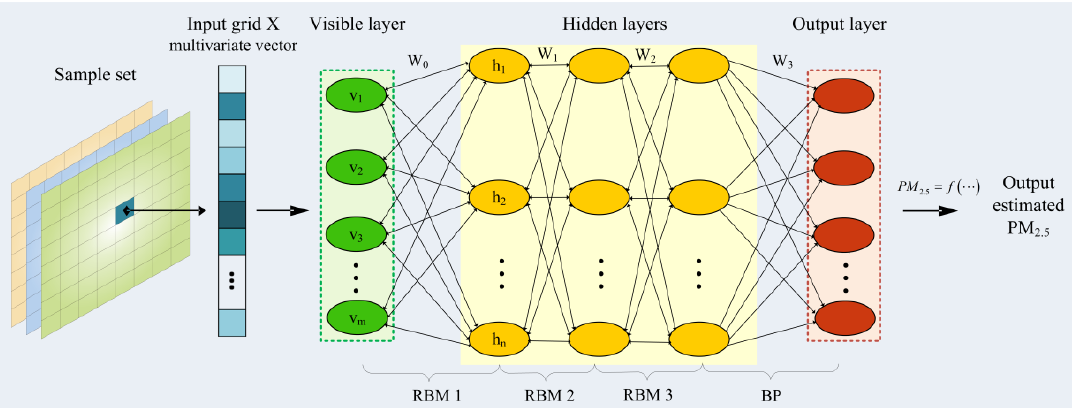
Figure 4. The structure of the DBN 1 for the estimation of PM 2.5 .